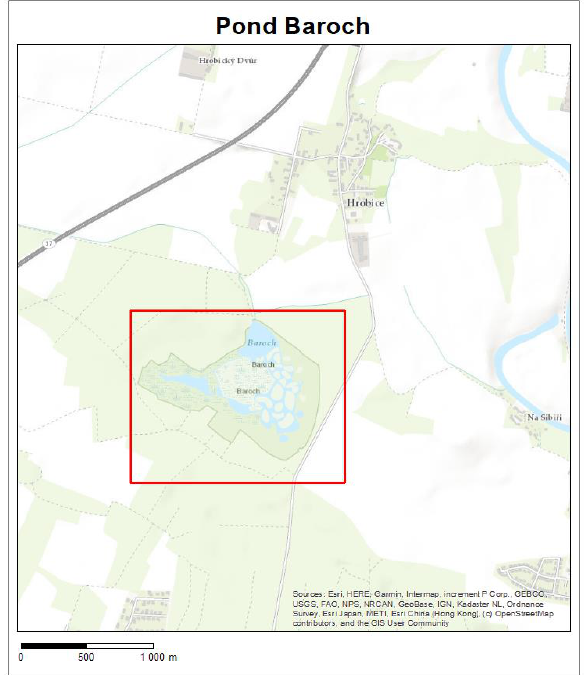
Figure 1 . Localization of pond Baroch (Esri,